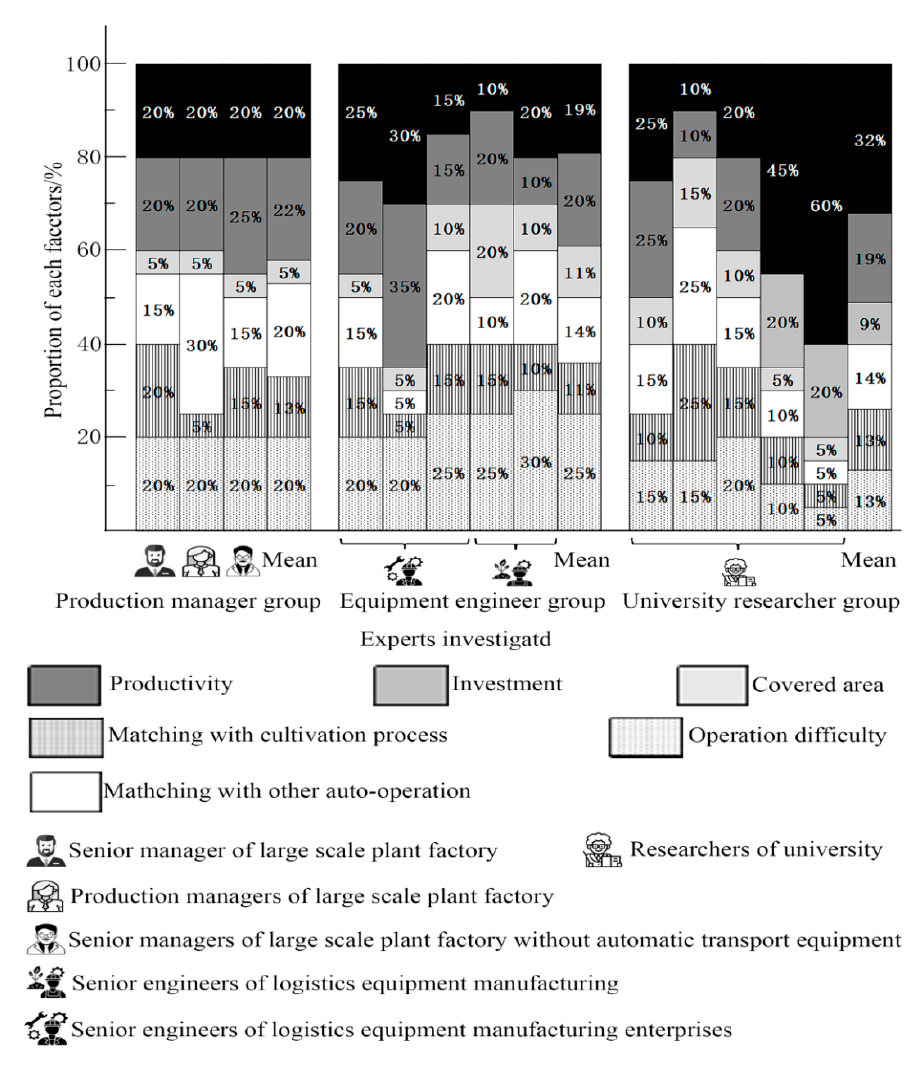
Figure 8. Views of experts investigated on the factors of plant factory construction .